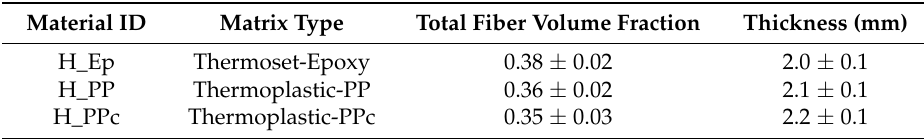
Table 1. Characteristics of the as-manufactured hybrid